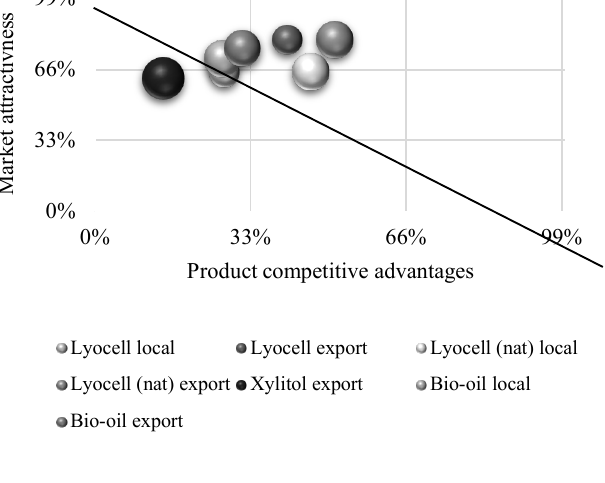
Fig. 3. Results in GE-McKinsey